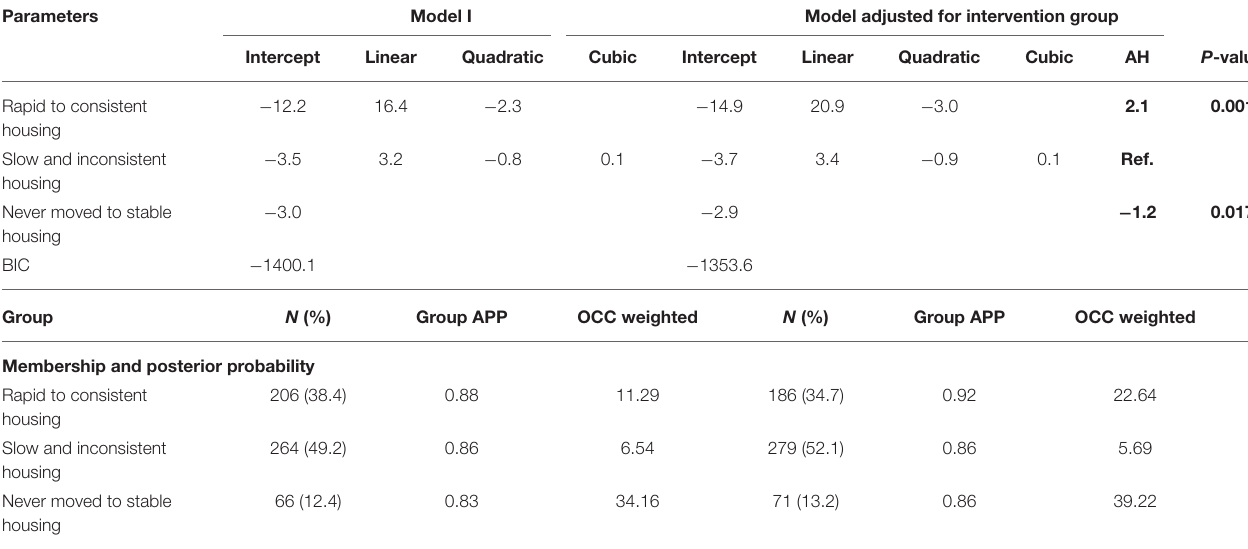
TABLE 2 | Housing Trajectory Groups adjusted from Group-Based Trajectory modeling.